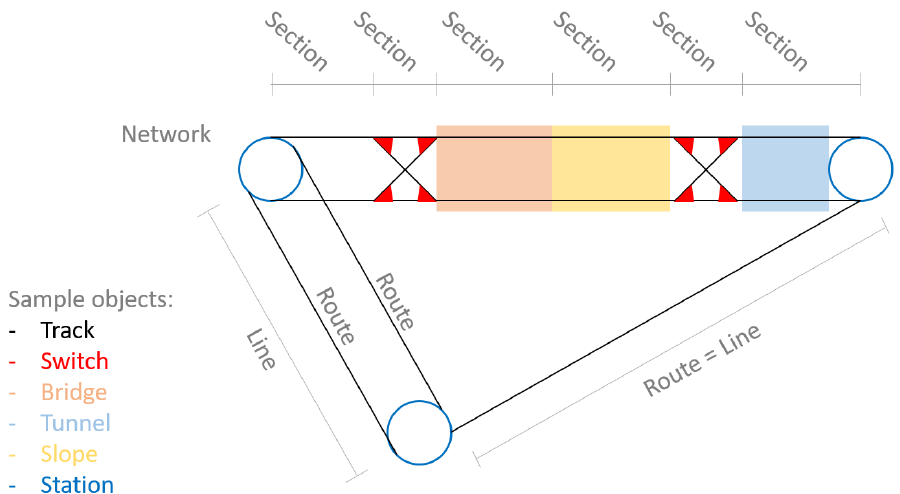
Figure 1. Topological structure.